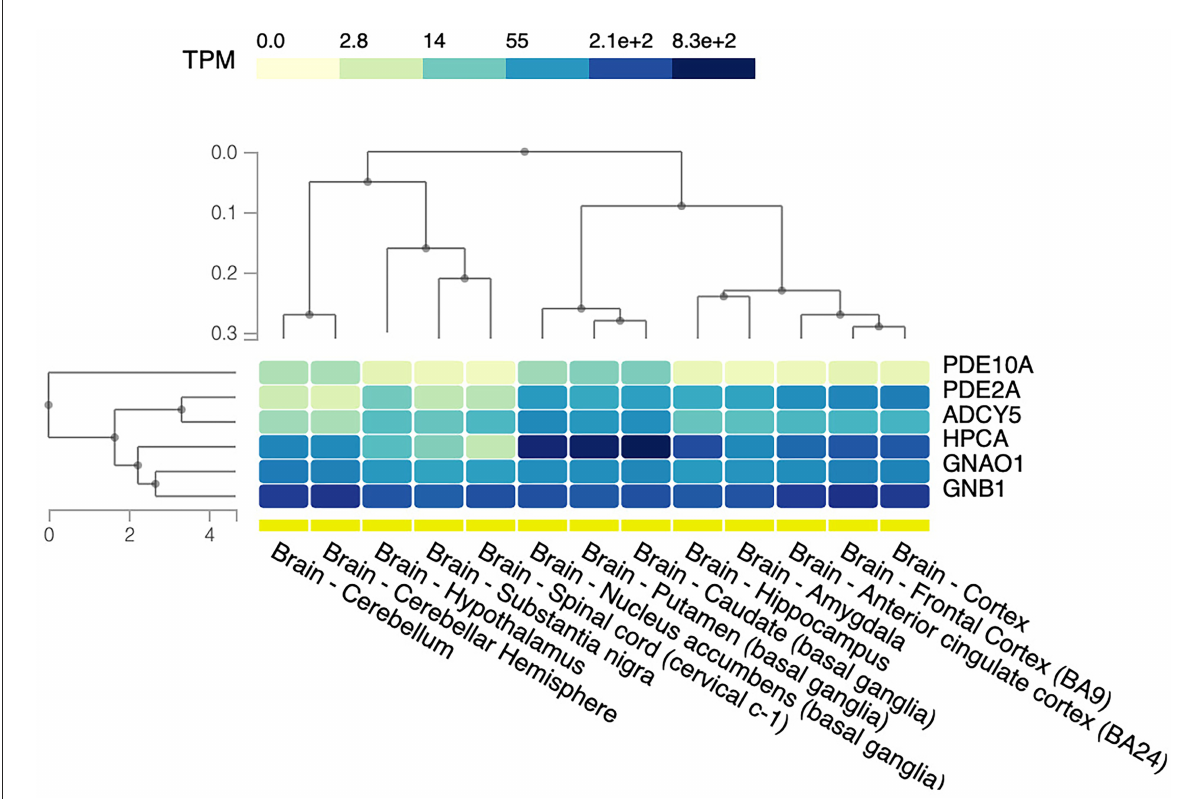
FIGURE5 Brain tissue expression of protein related to GPCRs–cAMP signaling. The heat map shows relative gene expression indicated as transcripts per kilobase per million mapped reads (TPM) based on the color scale. The data and image were obtained from: https://www.gtexportal.org, the GTEx Portal on 29/04/22. BA, Brodmann